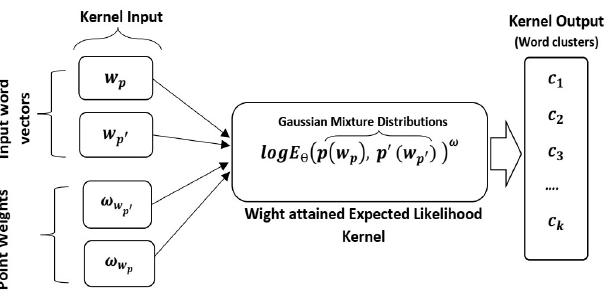
Figure 3. Block diagram of the semantic similarity measures between distributions of words using The Weight attained Expected Likelihood Kernel (weighted energy function).